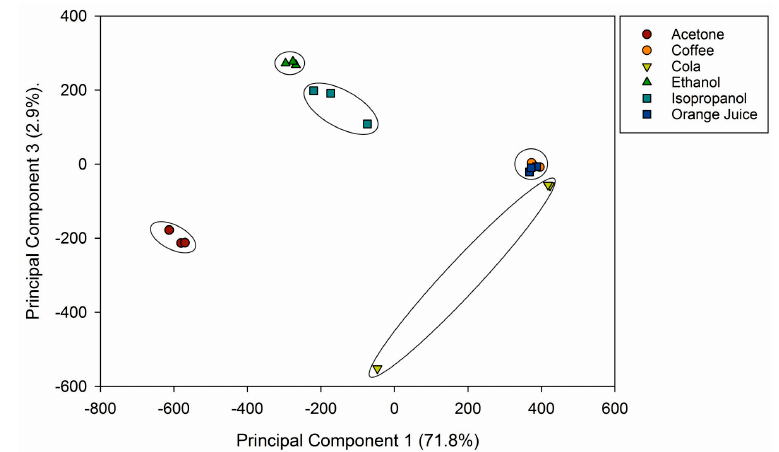
Figure 4. PCA classification separating all 6 groups of Acetone, Isopropanol, Ethanol, Coffee, Cole and Orange